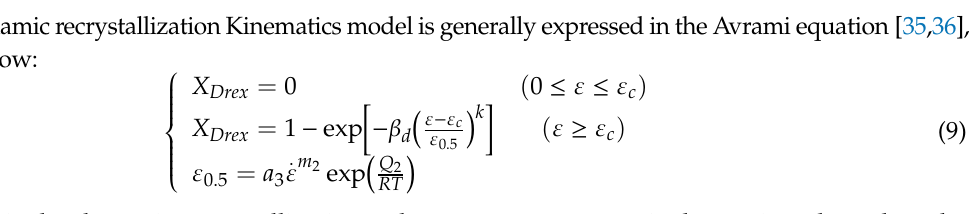
Figure 6. Material constant linear regression solution: ( a ) In ε p -In